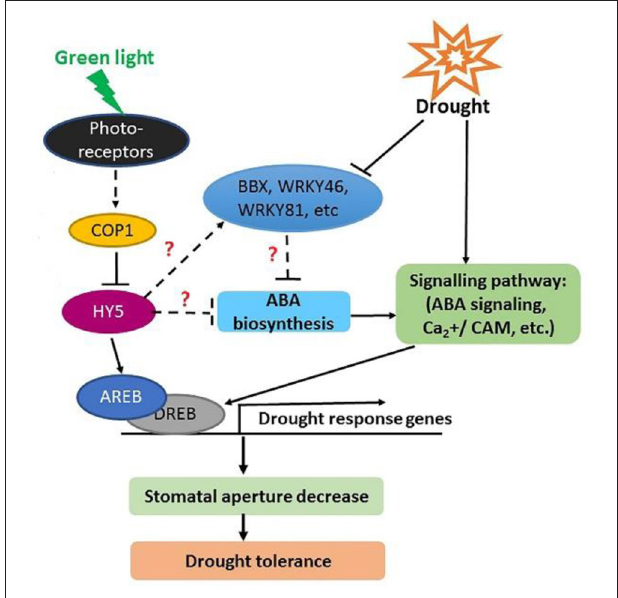
FIGURE 9 | A proposed model of green light enhances tomato drought